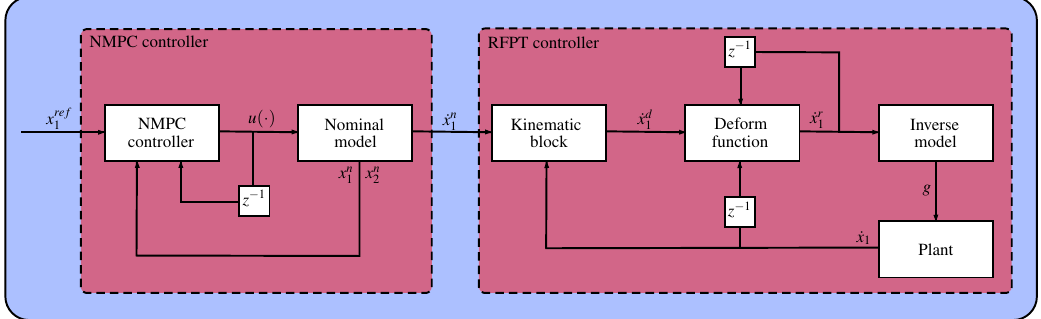
Figure 1. Schematic depiction of the combined NMPC-RFPT approach